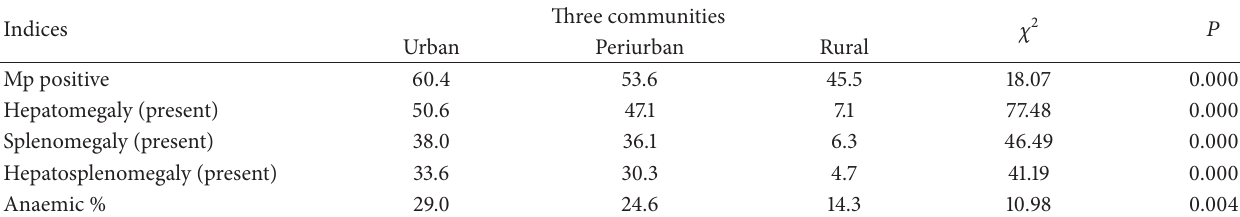
Table 2: Malariometric indices of asymptomatic carriers in three